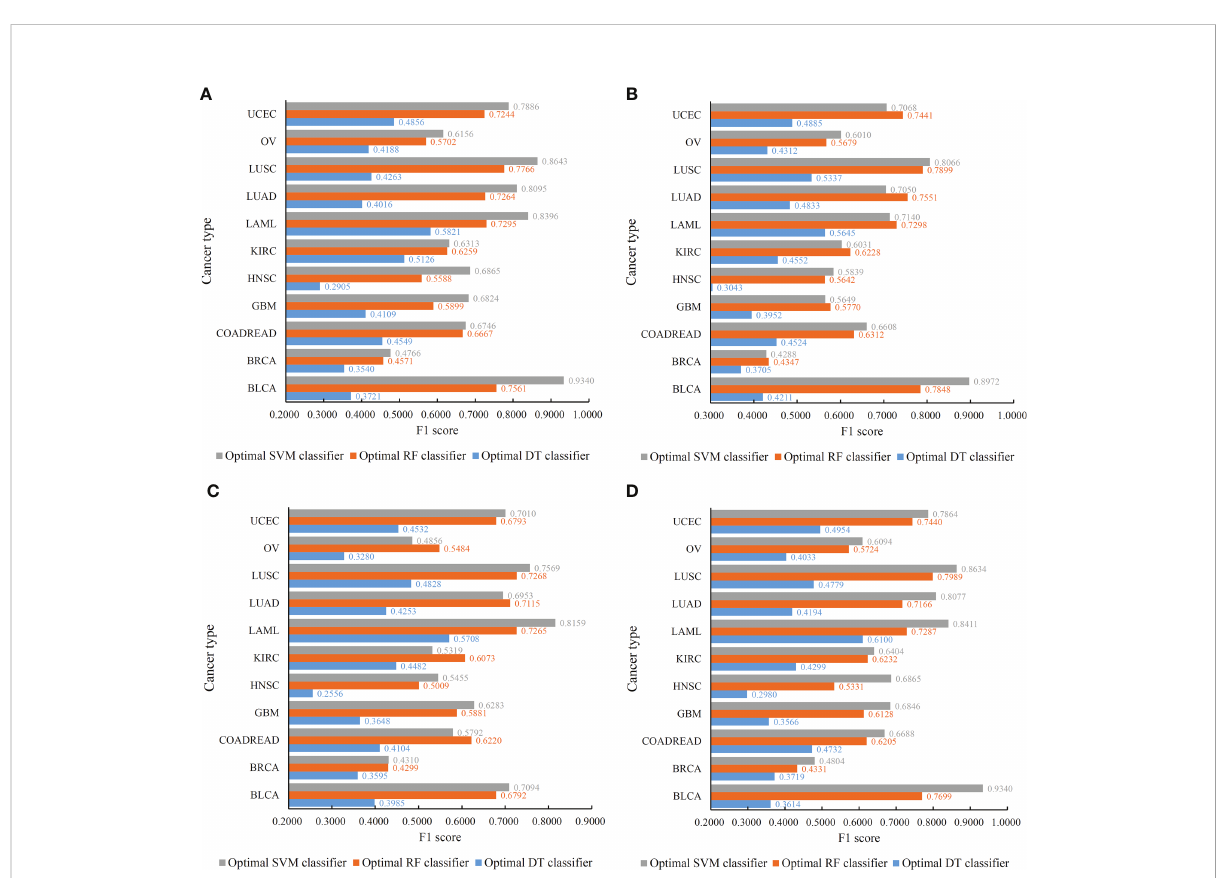
FIGURE 4 Performance of the optimal classi fi ers on eleven cancer types for different feature lists. (A) Lasso feature list; (B) mRMR feature list; (C) MCFS feature list; (D) LightGBM feature